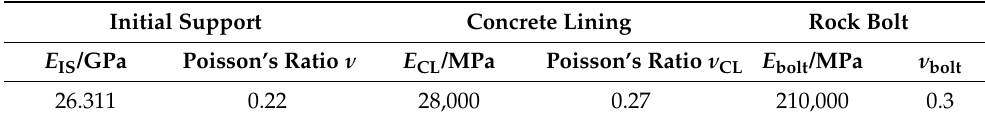
Figure 5. Collapse of tunnel primary support structure.